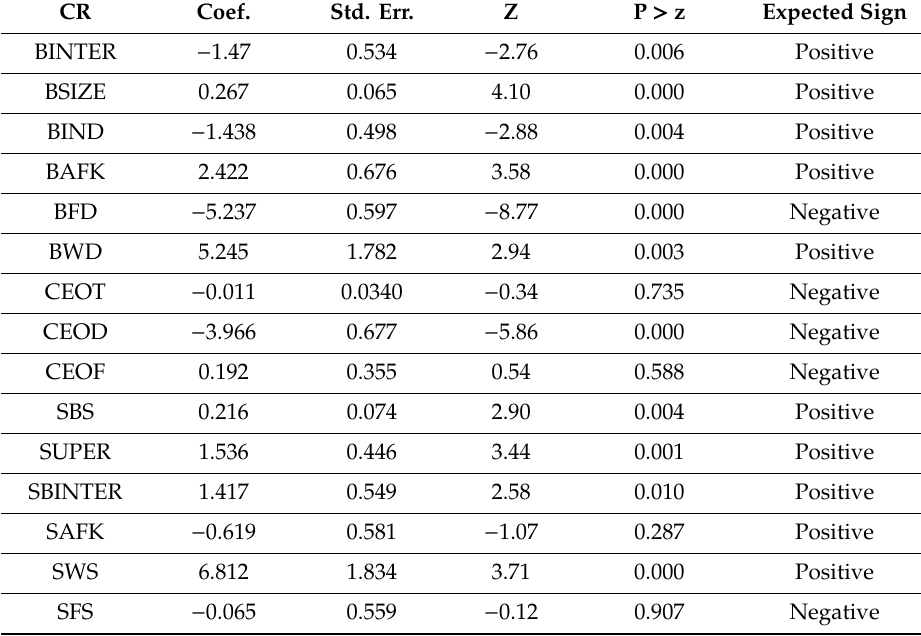
Table 5. Ordered logistic